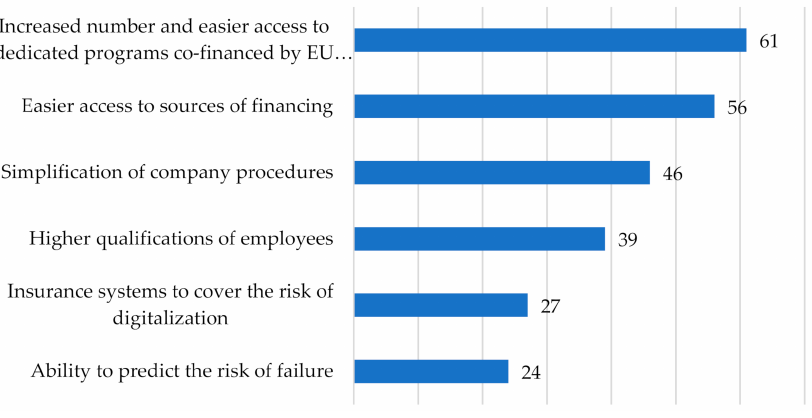
Figure 12. Actions that would support the implementation of Industry 4.0